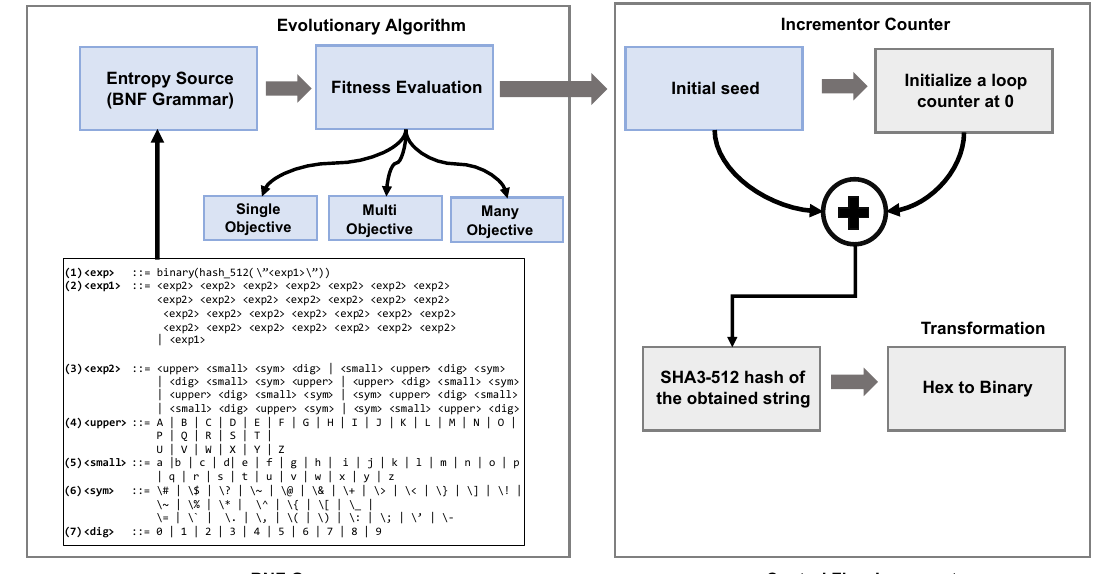
Figure 1. Pipeline for the design of GE-PRNG with the control_flow_incrementor approach. The process starts with using BNF grammar as entropy source to obtain the initial seed and subsequently, uses the seed as an input to the control_flow_incrementor function which generates random numbers.